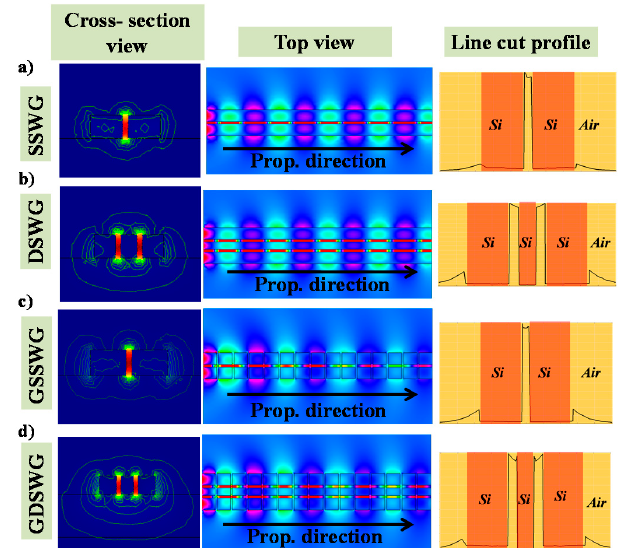
Figure 4. E-field distribution in the cross-sectional view, top view and line cut profile of electric field intensity of ( a ) SSWG, ( b ) DSWG, ( c ) GSSWG, ( d )GDSWG .